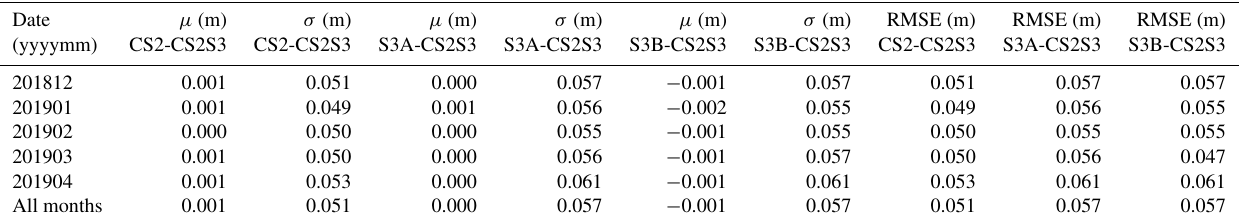
Table 1. Mean ( µ ), standard deviation ( σ ), and RMSE of the daily difference between gridded CS2, S3A, and S3B tracks and co-located CS2S3 points, for all days between the 1 December 2018 and the 24 April 2019. Also computed for all days in each respective